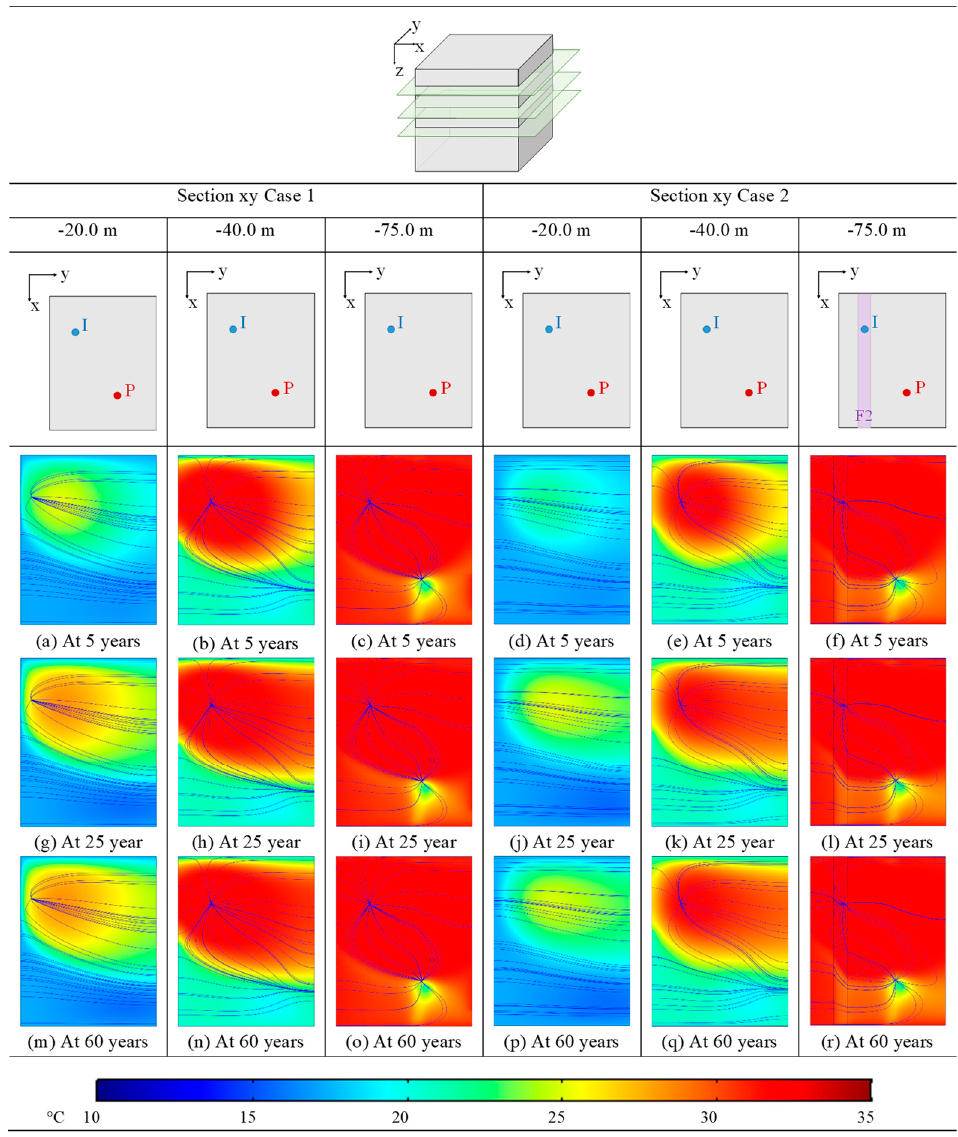
Figure 11. Temperature field at different depths and times, for Case 1 (single fault) and Case 2 (two faults).